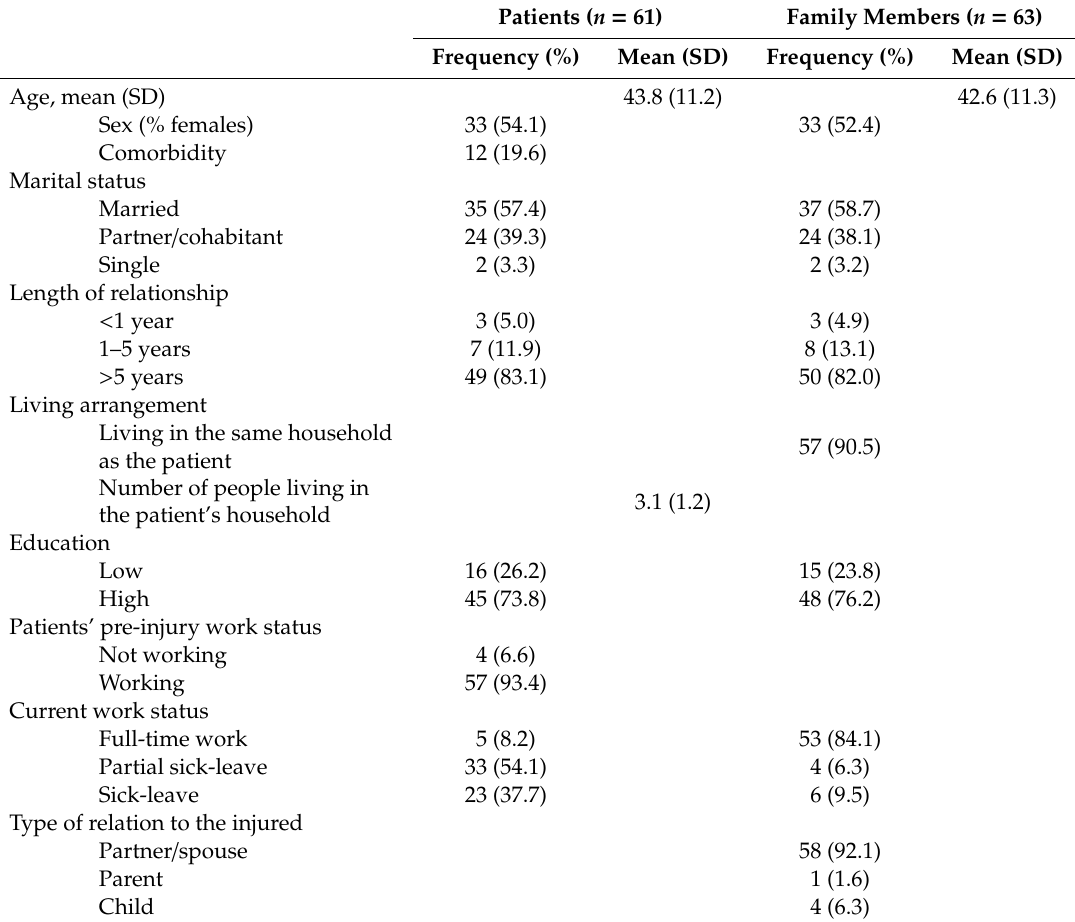
Table 1. Demographic factors of the 61 patients and 63 family members. SD, standard